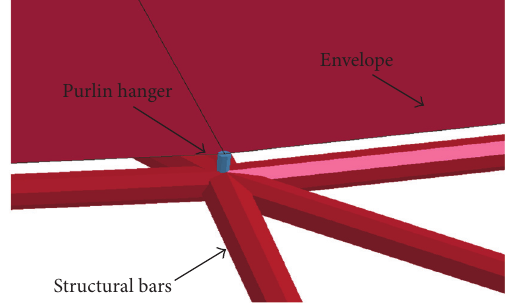
Figure 8: Schematic diagram of connecting